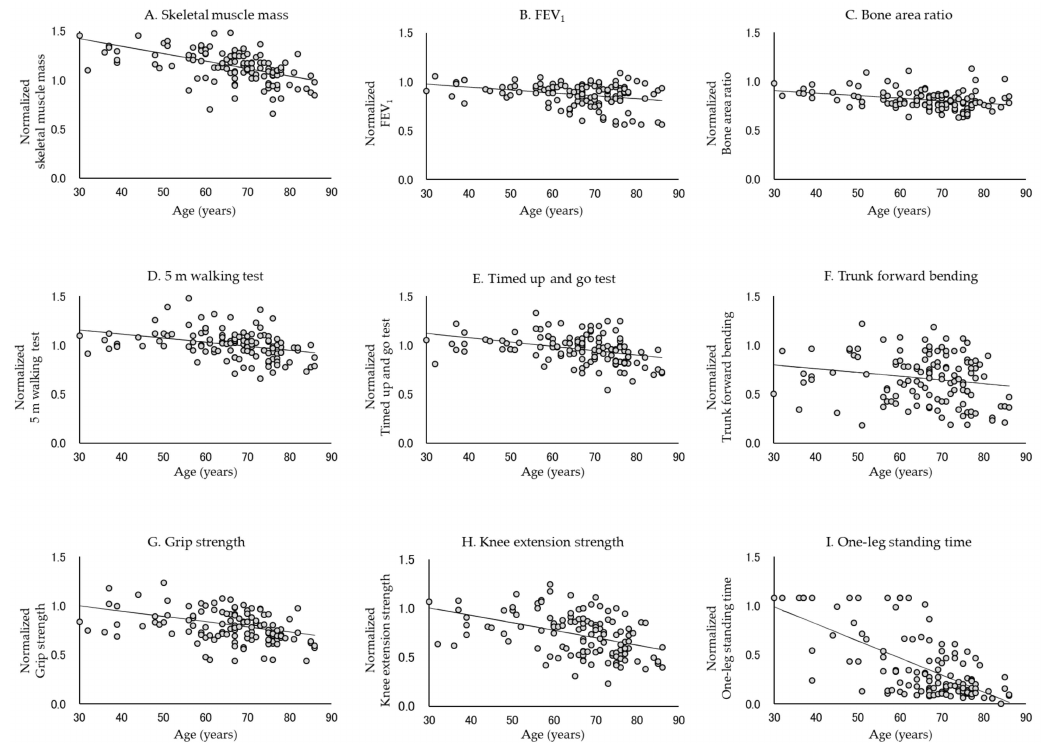
Figure 1. Normalized distribution and linear model of each physical function in all subjects. Each physical function declines with age. In particular, the rate of decrease in one-leg standing time, knee extension strength, and skeletal muscle mass was high.